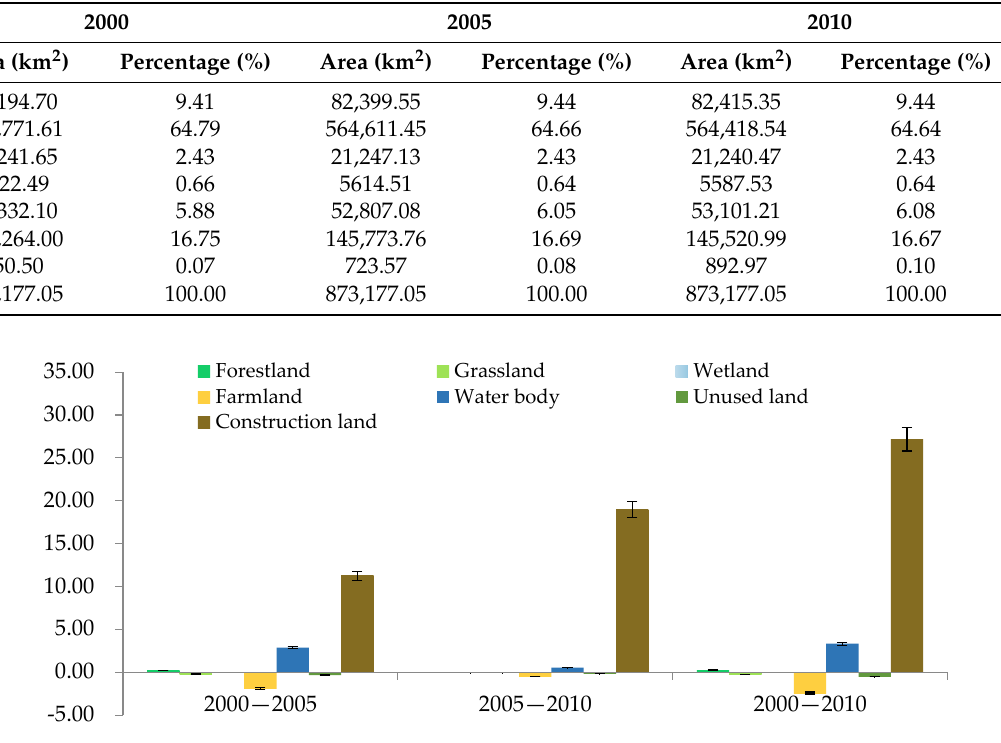
Figure 4. Land use in the national nature reserves of western China in 2010. Table 3. Land-use dynamics in the national nature reserves of western China.